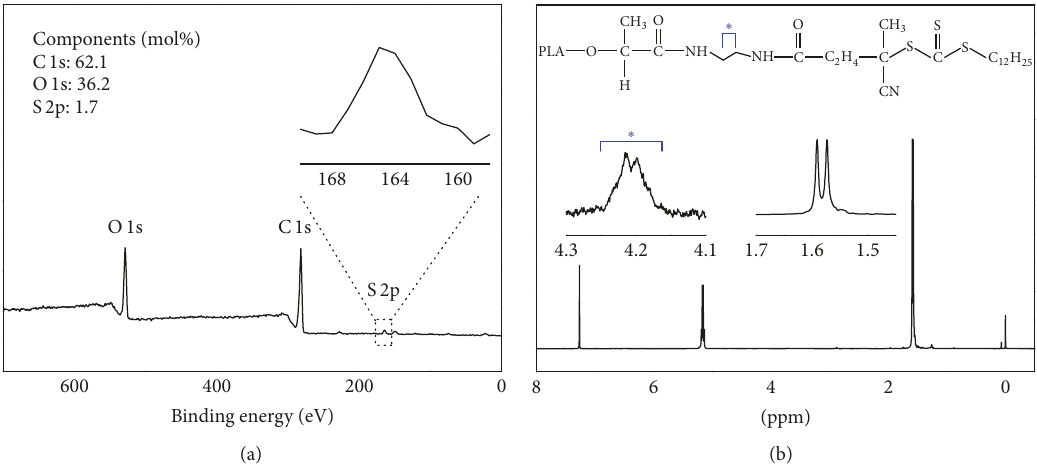
Figure 6: (a) XPS wide scan and elemental mole percentages and (b) 1 H NMR spectrum in CDCl 3 of PLA 345 -CDP.